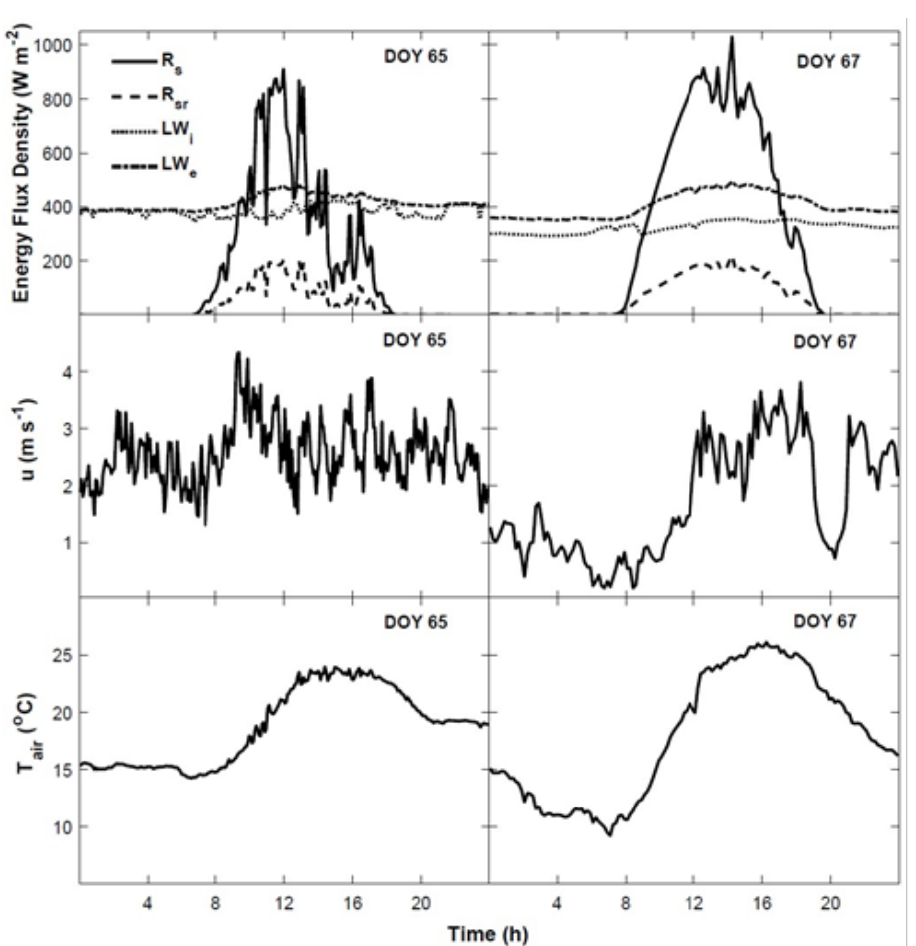
Figure 4. Environmental conditions on days of year (DOY) 65 and 67. Solar irradiance (R s ), reflected solar irradiance (R sr ), incoming longwave sky radiation (LW i ), emitted longwave radiation by the surface underneath the discs (LW e ), wind speed (u), and air temperature (T air ) were measured at the height of the discs.